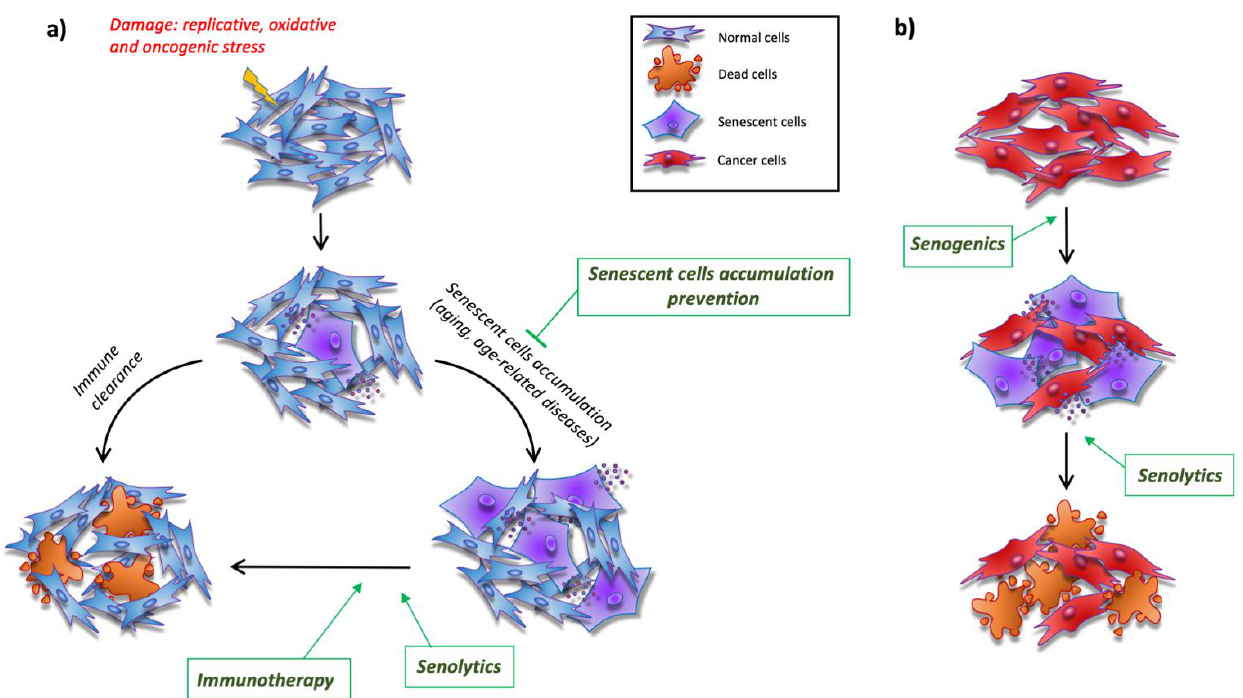
Figure 1. Cartoon summarizing the hypothesized interventions aimed at eradicating the chronic accumulation of senescent cells: ( a ) interventions suggested to prevent chronic diseases and improve health in aging; ( b ) the “one-two punch” strategy combining senogenic and senolytic therapies for the treatment of cancer.